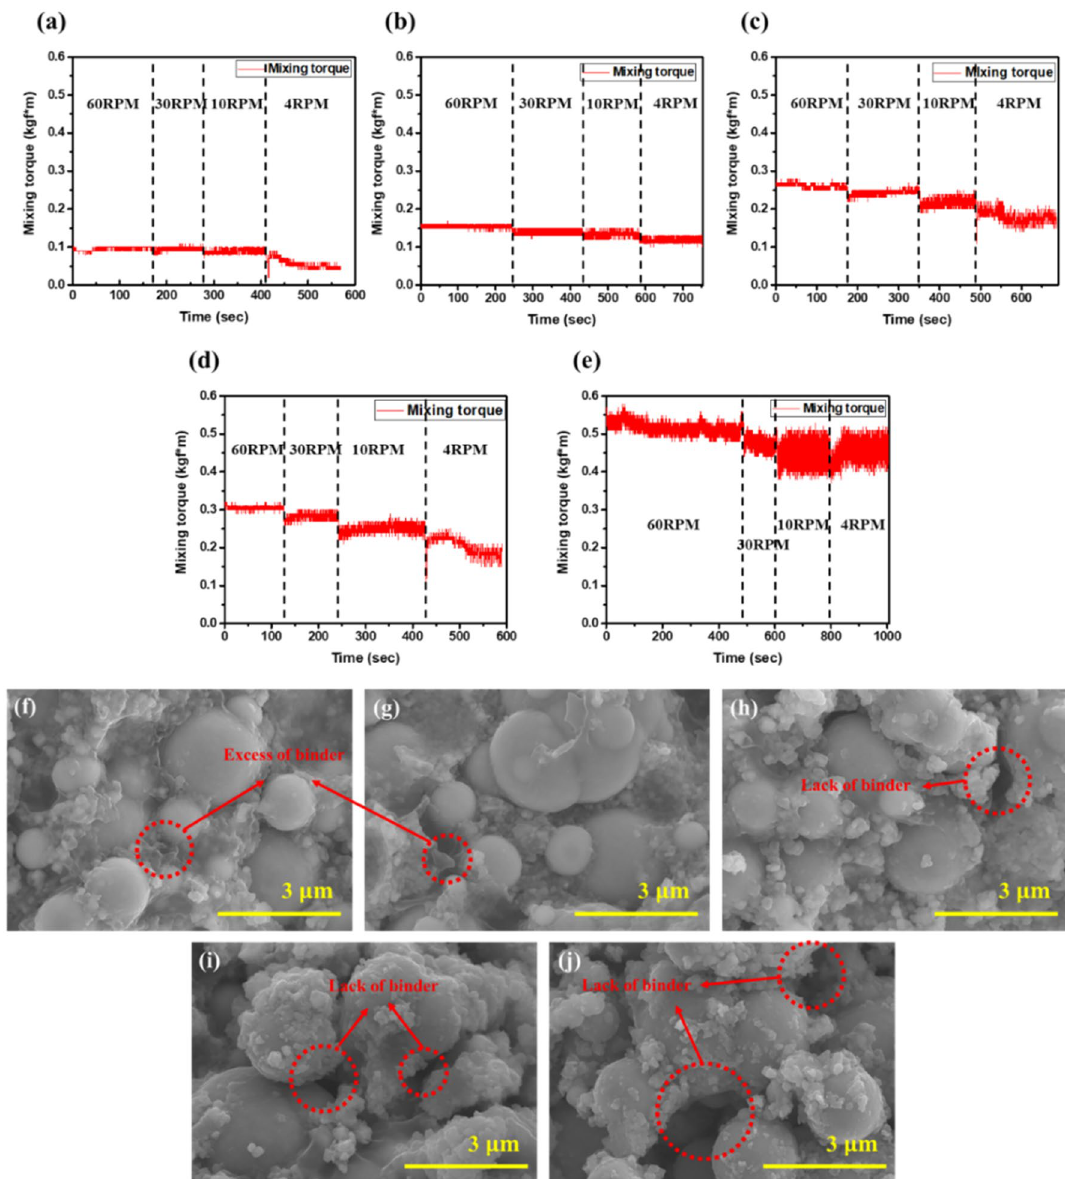
Figure 6. Mixing torque measurement results of varying trimodal feedstocks at different mixing speeds for ( a ) 60 vol.% ( b ) 65 vol.% ( c ) 70 vol.% ( d ) 75 vol.%, and ( e ) 80 vol%. SEM images of corresponding trimodal feedstocks for ( f ) 60 vol.%, ( g ) 65 vol.%, ( h ) 70 vol.%, ( i ) 75 vol.%, and ( j ) 80